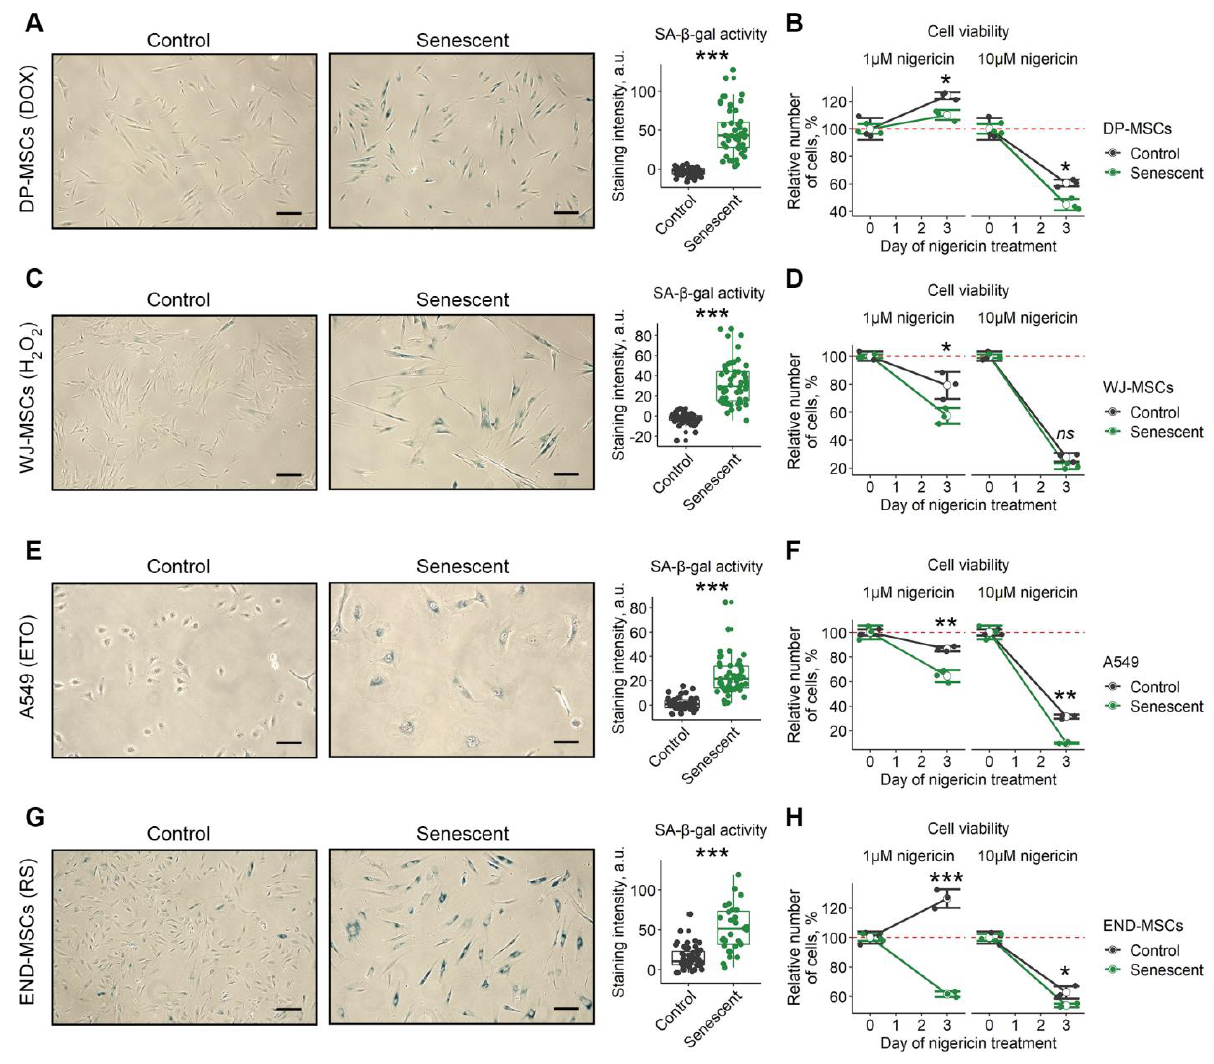
Figure 6. Nigericin can be used as a senolytic for cells of various origins. Four additional models of senescence of different cell lines was verified for acquisition of SA- β -gal activity and tested for the selective death of senescent cells: ( A , B ) control and doxorubicin- induced senescent (1 μM, DOX) DP-MSCs; ( C , D ) control and oxidative- stress induced senescent (100 μM, H 2 O 2 ) WJ-MSCs; ( E , F ) control and etoposide- induced senescent (3 μM, ETO) A549 cells; ( G , H ) control and replicatively senescent (RS) END-MSCs. Cell viability data presented as relative cell viability (%) of control and senescent cells 3 days after treatment. Values presented are mean ± s.d. For pair comparisons at ( A , C , E , G ), Welch’s t -test was used, n = 50, *** p < 0.005. For comparison of viability of control and